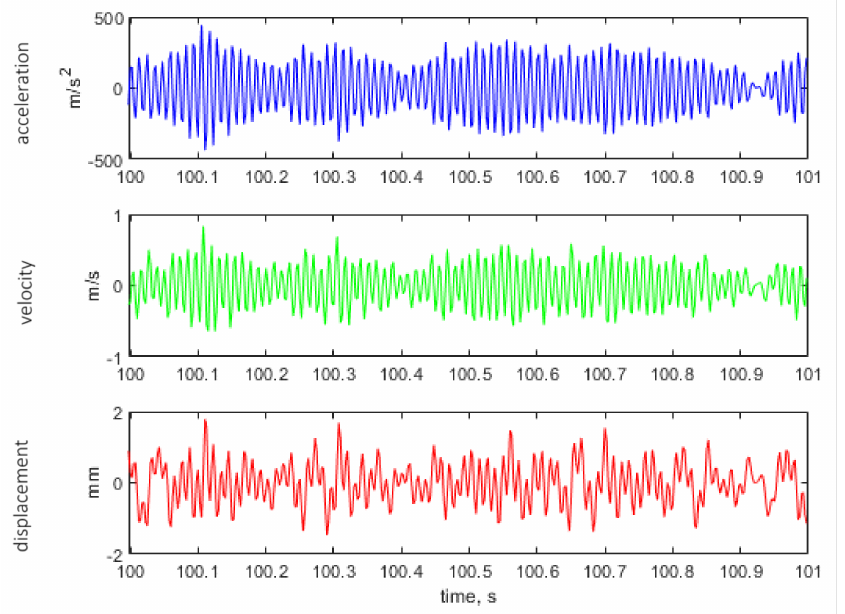
Figure 11. Representative time histories of acceleration measured on additional mass (see Figure 4) and the calculated velocity and displacement for the excitation signal with kurtosis parameter Ku =